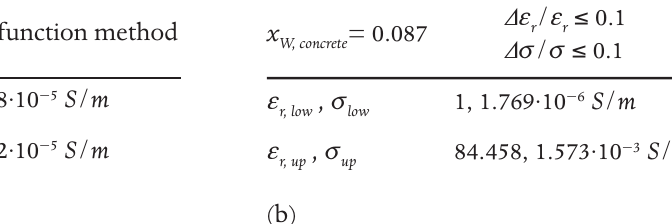
Table 2. Concretes: (a) comparing domains of v , foreseen by Sensitivity approach and Transfer method, once selected f x ; (b) domains of f and v where Df W, concrete